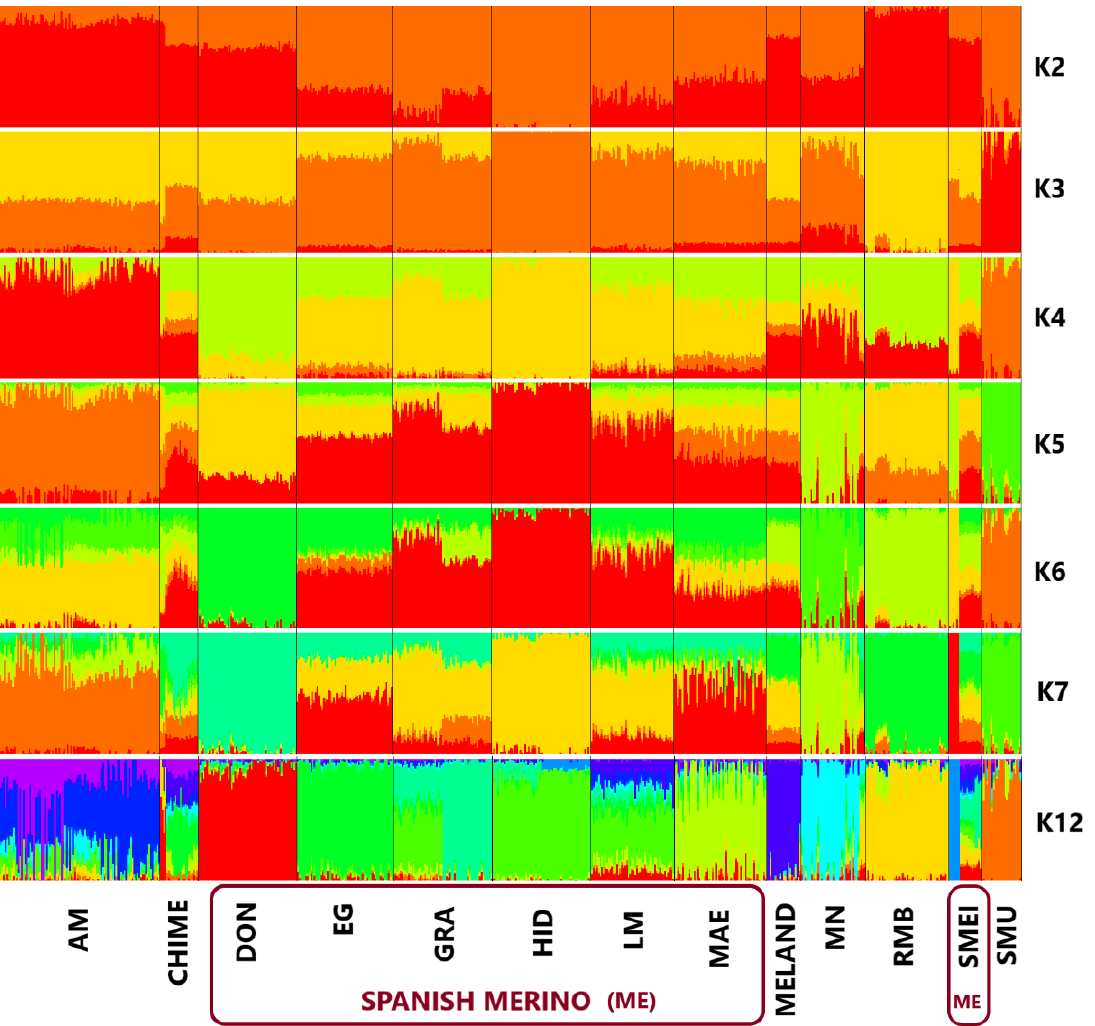
Figure 4. Plot of the population structure of the Merino breeds including the genetic lines of the Spanish Merino and the Mouflon employed in the study according to different K, including the optimal K (K = 12). K: number of populations assigned. Breeds: AM (Australian Merino), CHIME (Chinesse Merino), MELAND (Landschaf Merino), RMB (Merino of Rambouillet), MN (Spanish Black Merino). Genetic lines within the Spanish Merino: DON (Donoso), EG (Egea), GRA (Granda), HID (Hidalgo), MAE (Maesso), LM (L ó pez-Montenegro), SMEI (Spanish Merino from Industrial Breeding). Outgroup species: SMU (Mouflon).